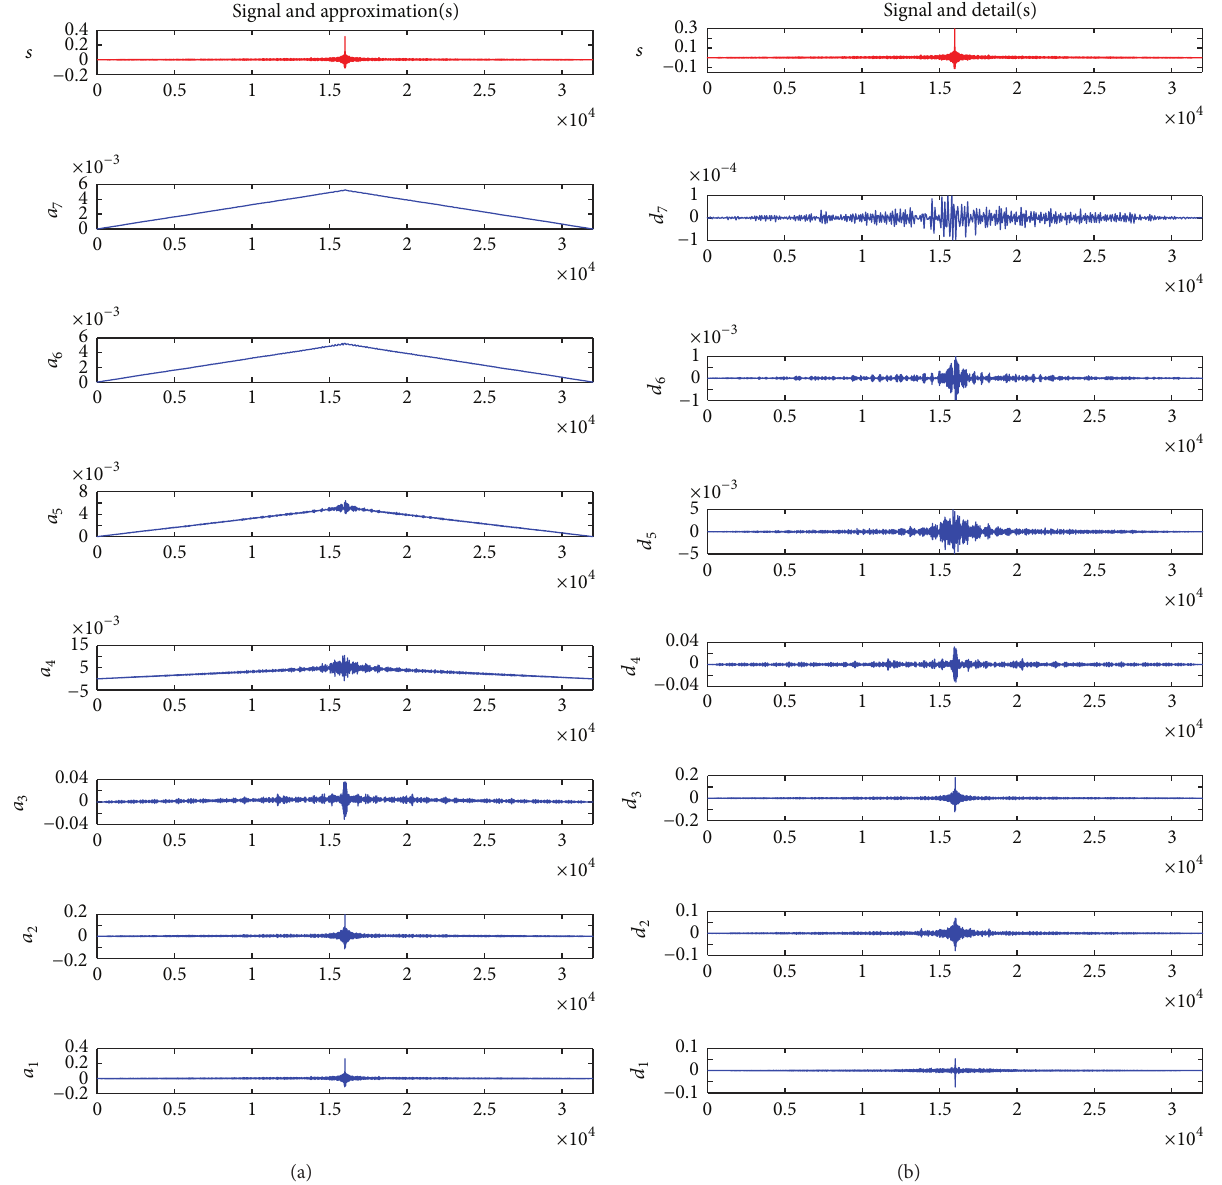
Figure 3: Autocorrelation and DWT decomposition for a healthy motor, (a) approximation, and (b) detail.